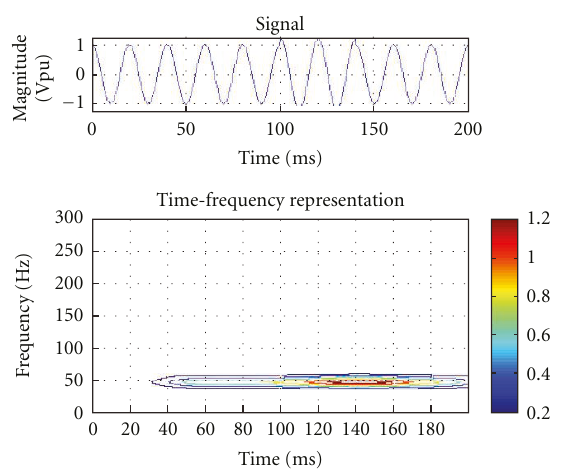
Figure 14: The TFR of swell signal using BD at β = 0 . 001.